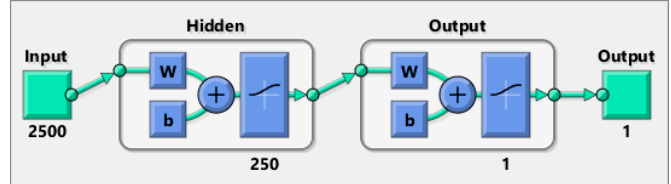
Figure 9. Neural network architecture used in verifying anonymity.